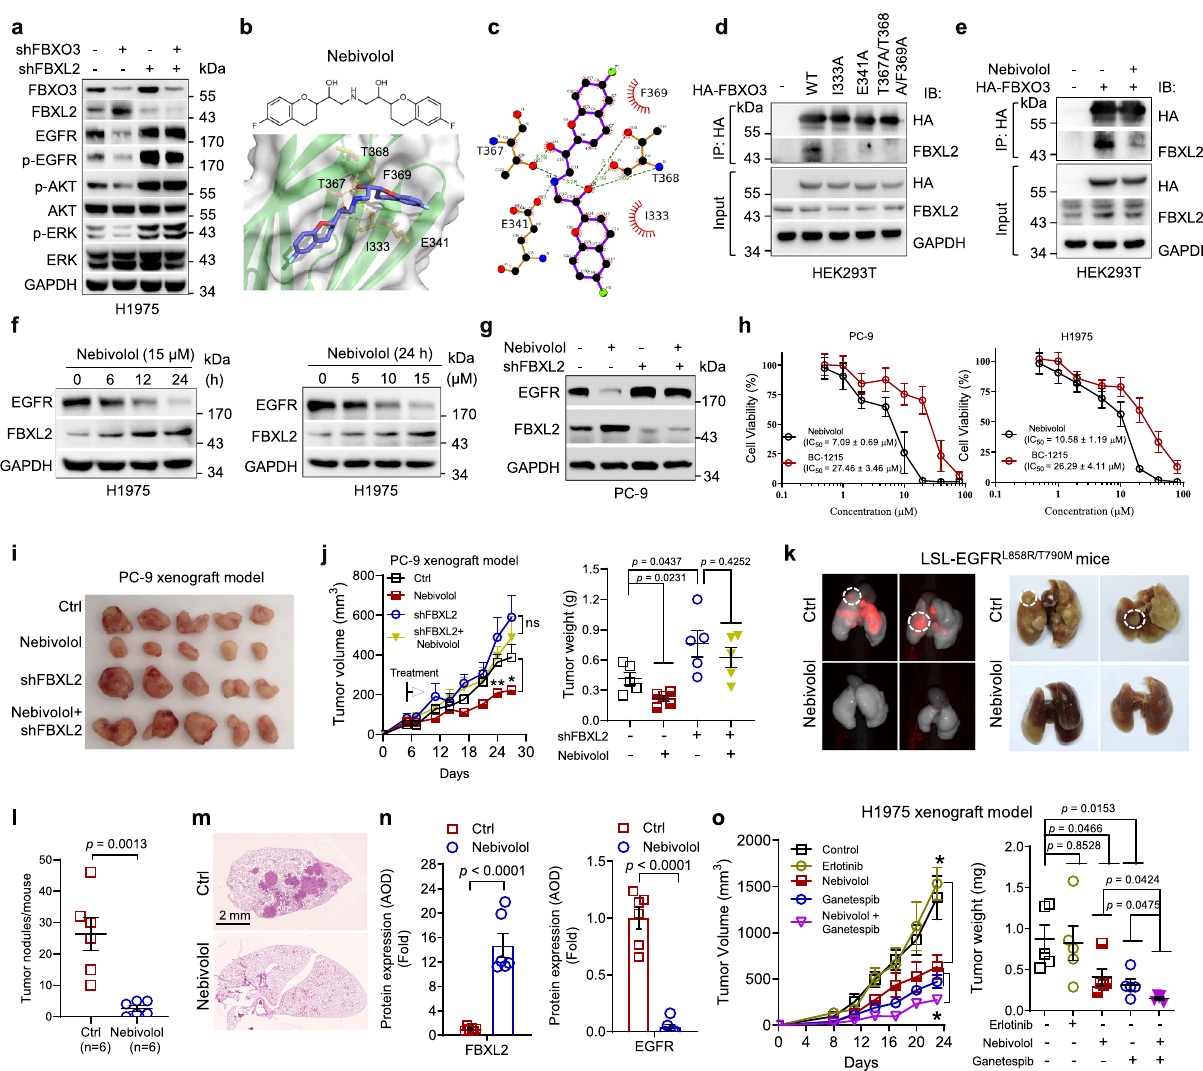
Fig. 6 Nebivolol upregulates FBXL2 to facilitate EGFR degradation and inhibit tumor growth. a H1975 stable cells were subjected to Western blot analyses. b The chemical structure of nebivolol and a molecular docking model of nebivolol and FBXO3-ApaG domain. c A schematic diagram of the projected interaction by LigPlot 65 between indicated residues in FBXO3-ApaG domain and nebivolol. The hydrogen bonds or electrostatic interaction are highlighted in green or blue dash lines, respectively. The hydrophobic interaction is remarked as the short radiating red lines. HEK293T cells transfected with the indicated expressing plasmids were treated without ( d ) or with ( e ) 10 µ M nebivolol for 36 h. Cells were treated with MG132 prior to IP-Western analyses. f H1975 cells were treated with nebivolol for an indicated dose and time interval prior to Western blot analyses. g PC-9 stable cells were treated with 10 µ M nebivolol for 48 h prior to Western blot analyses. h The IC 50 of PC-9 or H1975 cells treated with nebivolol or BC-1215 were determined by MTS assays. Data were presented as means ± SD. i , j PC-9 stable cells subjected to xenograft tumor growth assays ( n = 5/group). Photos of tumors, growth curve, and tumor weight were presented. k − n Transgenic mice (Rosa26-LSL-EGFR L858R/T790M ) were used ( n = 5/group). k The representative fl uorescent images and photos of lungs were shown. Fluorescence in red indicates high EGFR expression. Representative tumors with high levels of EGFR expression were shown in broken line of circles. l The numbers of observable nodules on the lung surfaces were presented. Paraf fi n-embedded lungs were sectioned and subjected to either m H&E staining or n IHC analyses. A speci fi c polyclonal antibody for mouse FBXL2 was custom-made from Hangzhou HuaAn Biotechnology Co., Ltd. (Hangzhou, China). o H1975 cells (5 × 10 5 ) were subjected to xenograft tumor growth assays ( n = 5/group). Growth curve and tumor weight were presented. The experiment was repeated three times independently with similar results ( a and d − h ). Data were presented as means ± SEM ( j , n , and o ). * p < 0.05, ** p < 0.01, *** p < 0.001; by two-tailed Student ’ s t -test. Source data are provided as a Source data fi